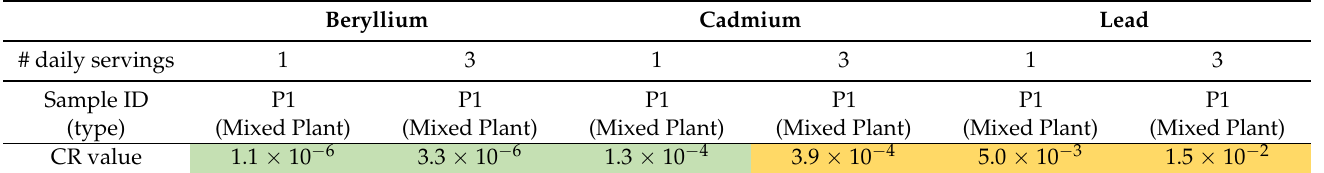
Table 9. Maximum recorded cancer risk (CR) values in